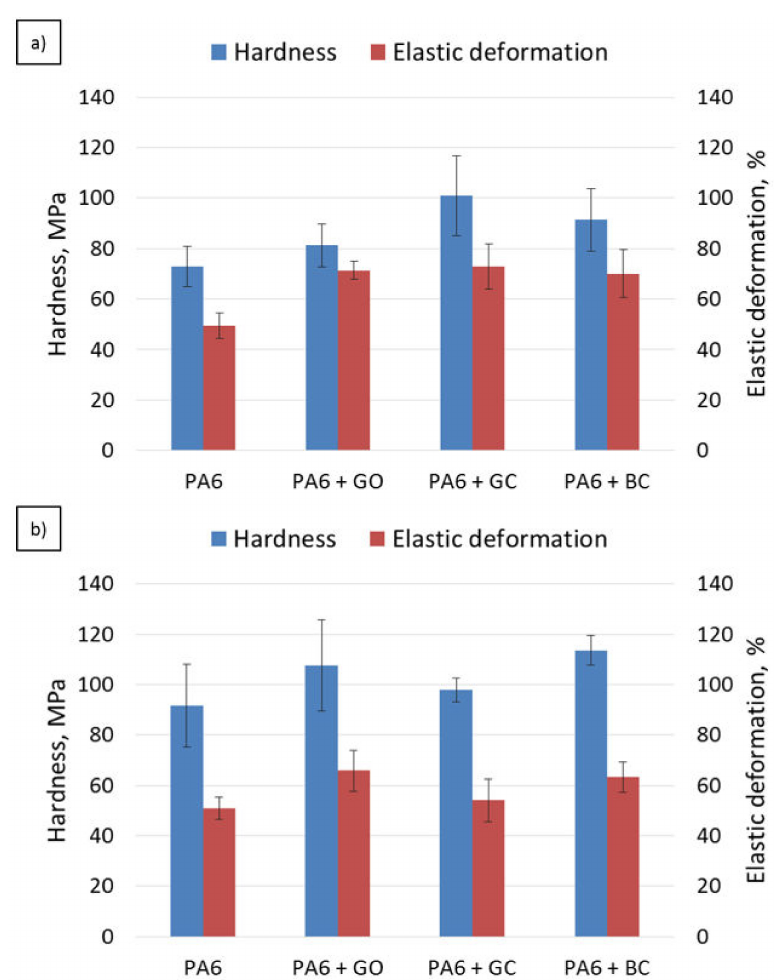
Figure 9. Hardness and elastic deformation results: ( a ) as injected, ( b ) after heat treatment.